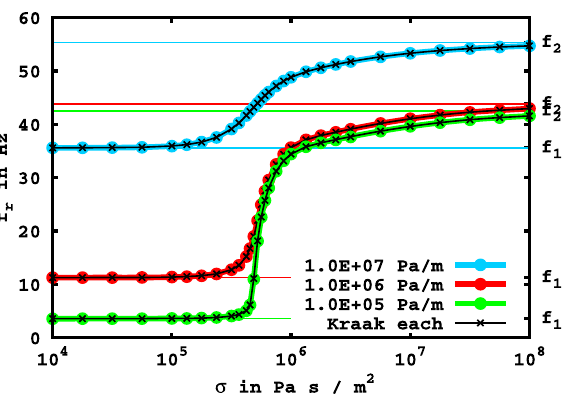
Figure 8. Resonance frequencies f r for different values of the Figure 6. Resonance frequencies f r for different values of the porosity e according to the legend, Kraak ’ s respective solutions stiffness per unit area of the solid structure s 0 according to the s for comparison, lines for asymptotes at f 2 in according legend, Kraak ’ s respective solutions for comparison, lines for asymptotes at f 1 and f 2 in according colors.